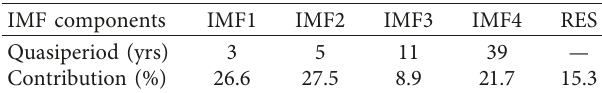
Figure 3: Significance test for the IMFs of Pavg (a) and Tavg (b) anomaly during 1961–2009 over the upper reach of the YZRB. Table 2: Variance contribution rates of IMFs and RES component to Pavg series.